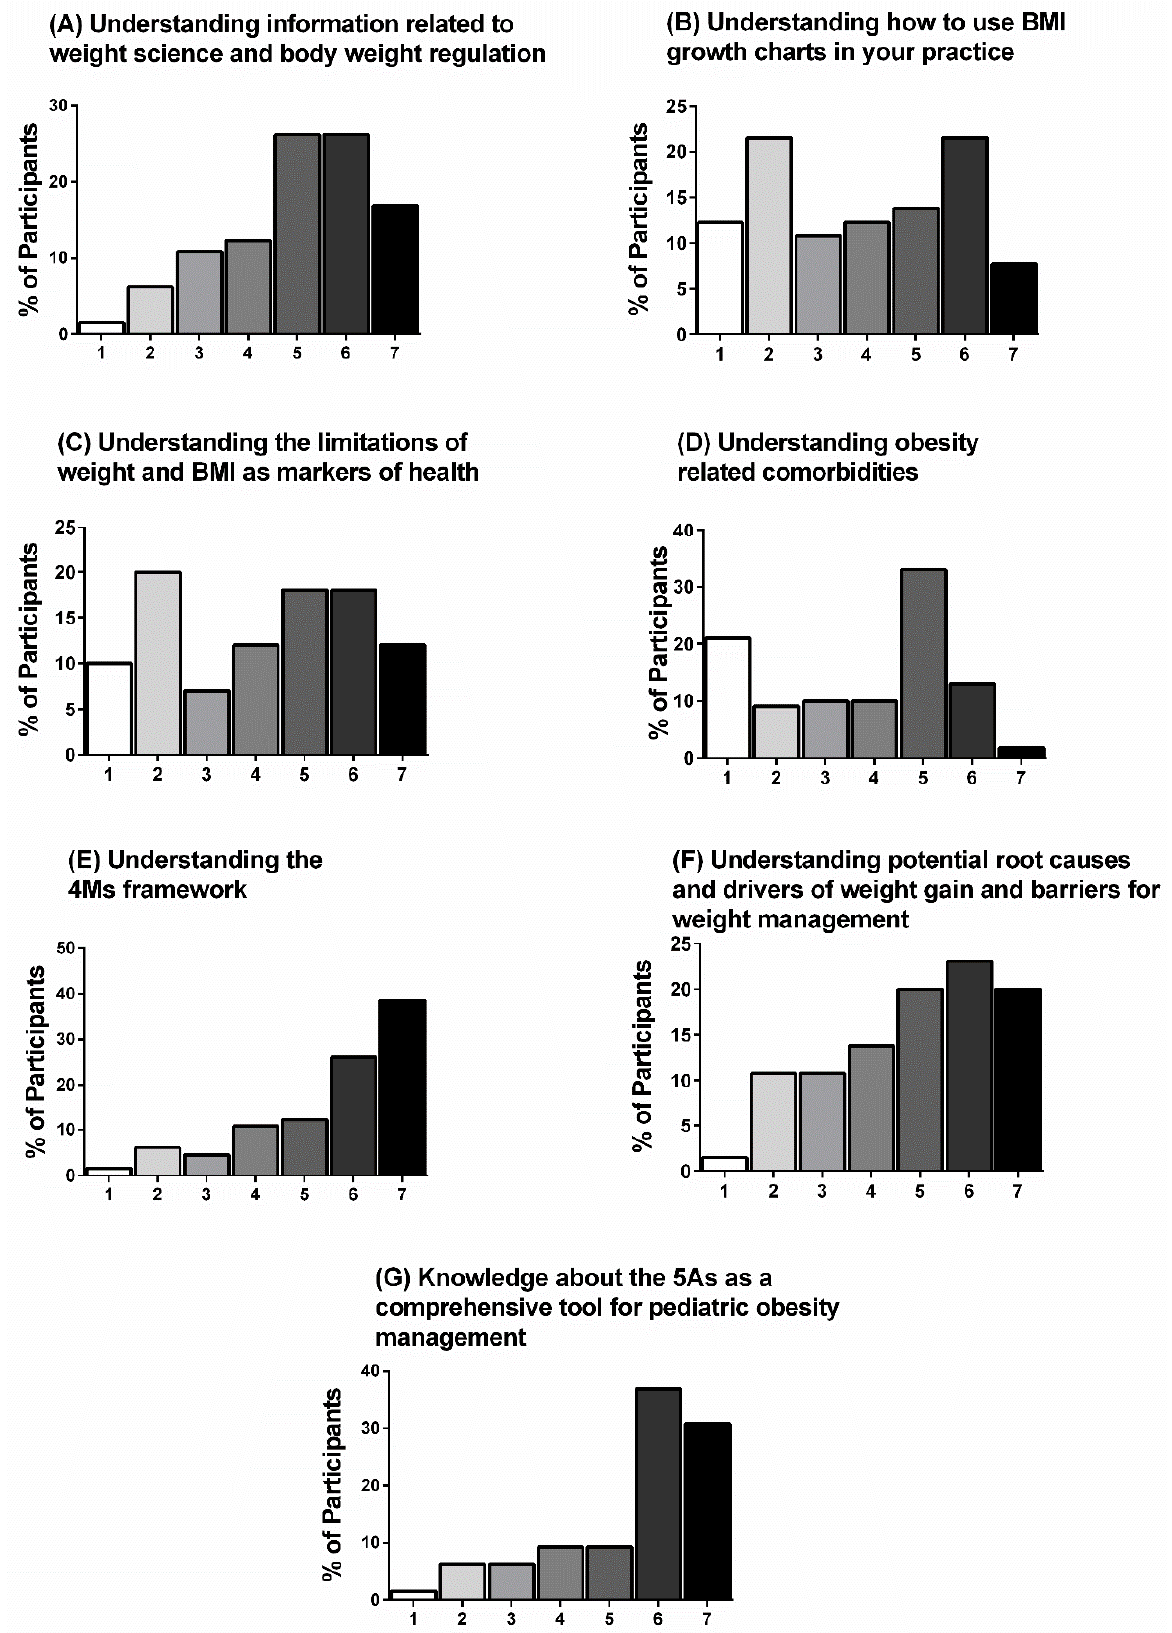
Figure 2. ( A – G ) Post-video change in knowledge. Participant agreement (%) measured using a Likert-type scale (1 to 7, where 1 = No change (or reduction in knowledge), 2 = Almost the same, 3 = A little better, 4 = Somewhat better, 5 = Moderately better, 6 = Better, and 7 = A great deal better) is shown for each statement ( n = 65).